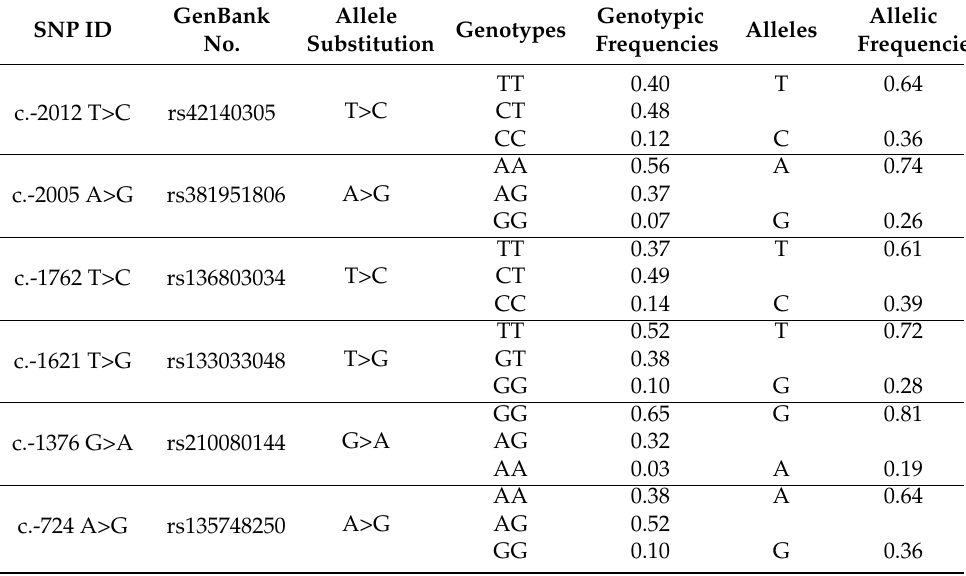
Table 2. Genotypes and allelic frequencies of the six SNPs in the 5 1 regulatory region of PDE9A. SNP ID